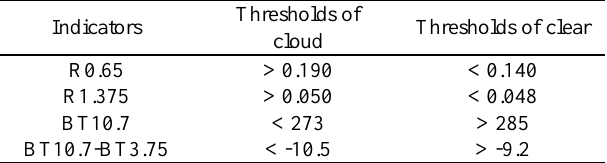
Table 4. Cloud detection thresholds for four